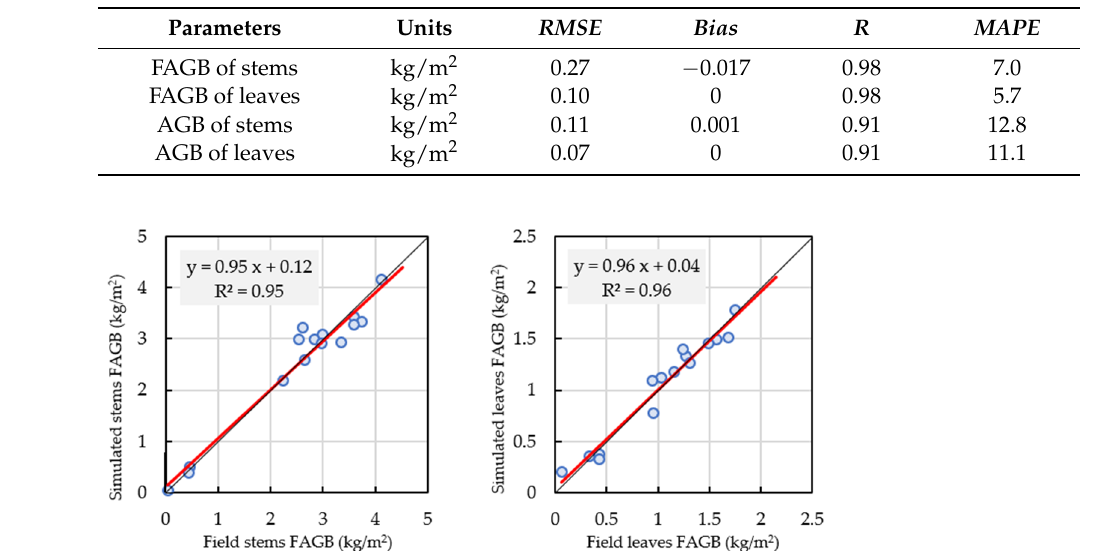
Table 4. The simulation accuracy indicator results for the FAGB and AGB in the simulated values of the maize stems and leaves compared to the field-measured values, respectively.